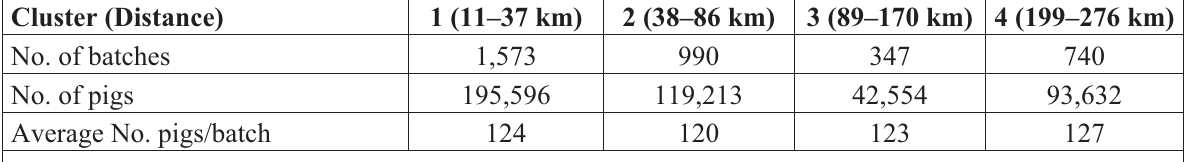
Table 2. Distance and transport conditions for batches and pigs based on